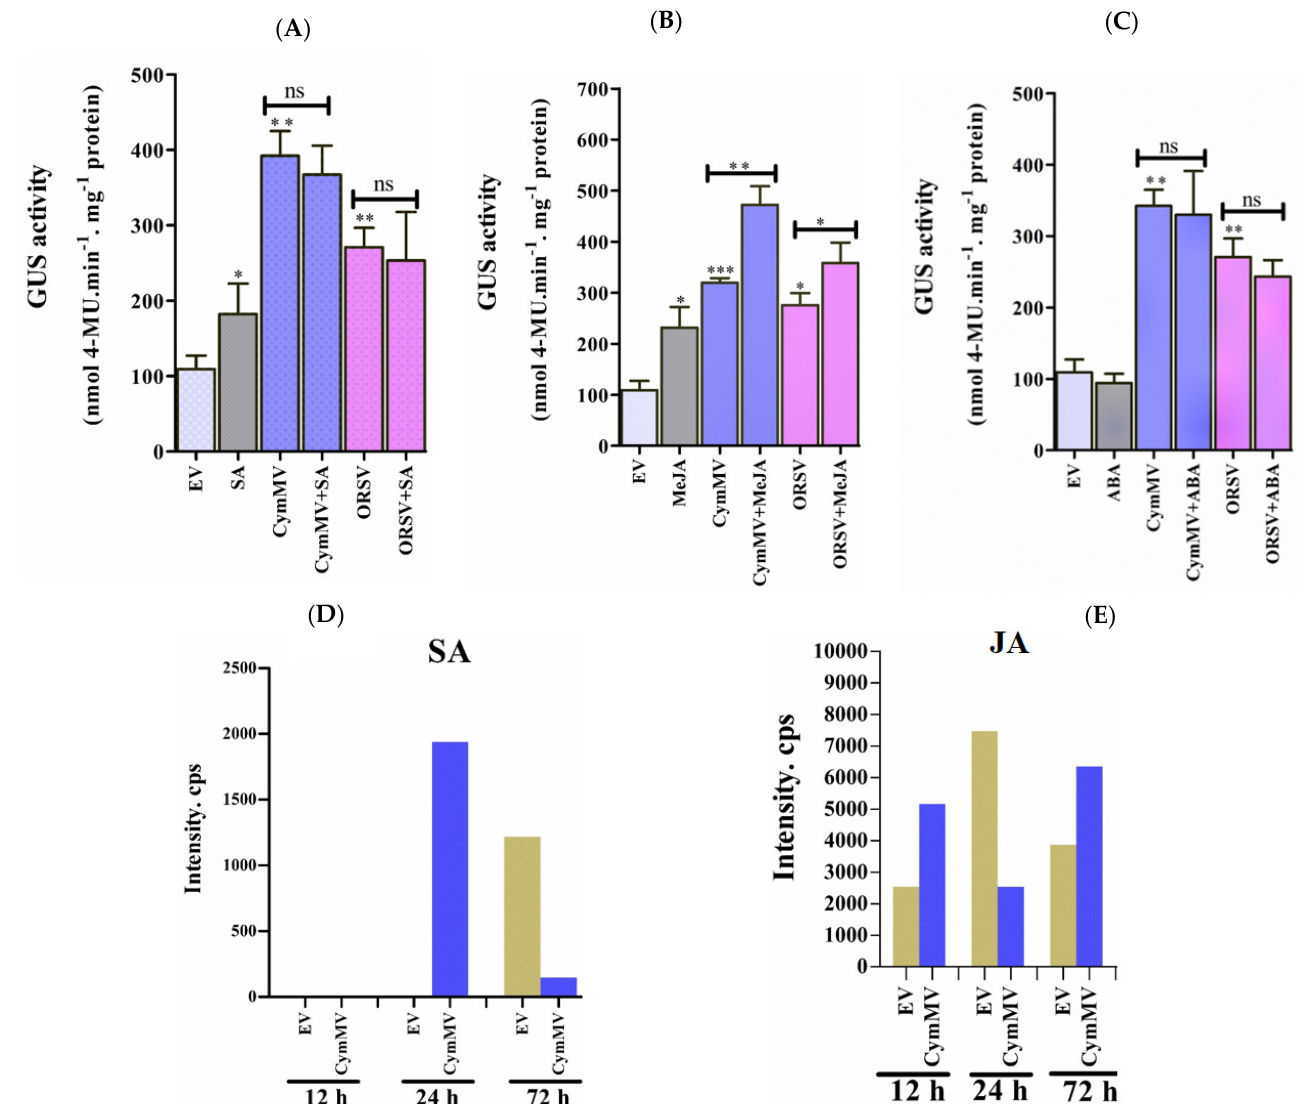
Figure 7. GUS fluorescent quantitative analysis during exogenous application of phytohormones and measurement of endogenous SA and JA levels. The activity of GUS driven by the p PaAGO5b measured during exogenous application of ( A ) 1 mM SA, ( B ) 100 µM MeJA, and ( C ) 100 µM ABA treatment alone or virus infection alone or a combination of phytohormones and virus infection in transgenic N. benthamiana leaves at 3 dpi. Effect of each hormone on GUS activity was assayed at least three times in four independent experiments. The GUS activity, 4-MU nmol-produced min − 1 mg − 1 protein, is represented as the mean ± SD. Data are mean ± SD, * p < 0.05, * * p < 0.01, ** * p < 0.001 by Student t -test, respectively. ns = non-significant. ( D ) The content of endogenous SA and ( E ) JA levels in N. benthamiana during the infiltration of EV (pKn) and CymMV infection at 12, 24, and 72 hr. The intensity of SA and JA was measured by the ultra-high performance liquid chromatography-electrospray ionization tandem mass spectrometry (UHPLC-ESI-MS/MS) method.